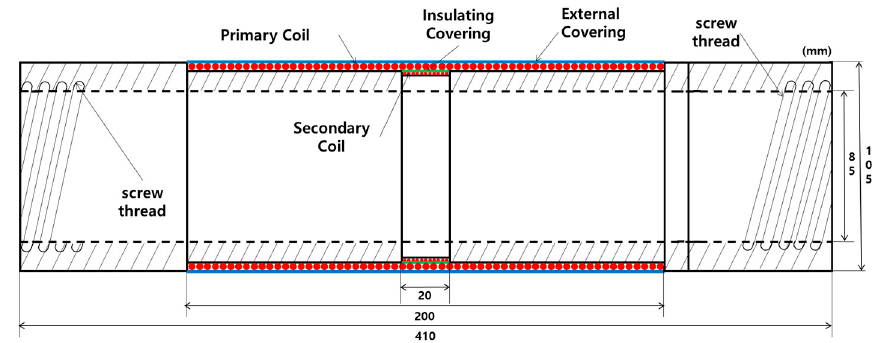
Figure 1. Schematic of the embedded EM sensor.